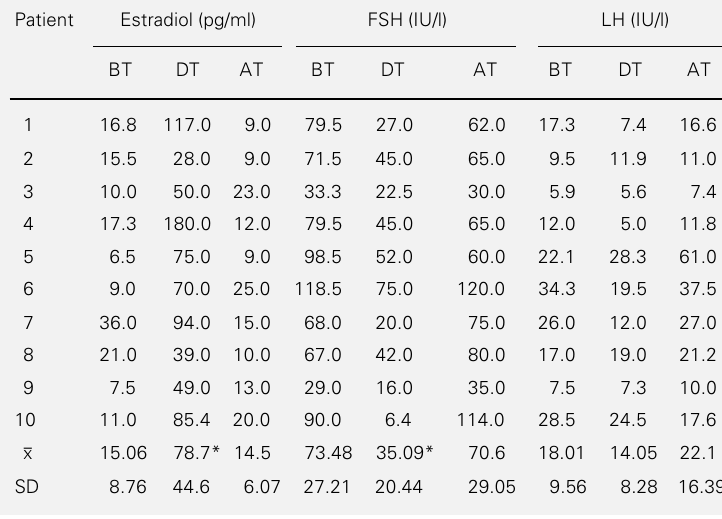
Table 1 - Hormonal profile of patients at the three periods studied (BT = before treatment, DT = during treatment, AT = two months after discontinuation of treat- ment).